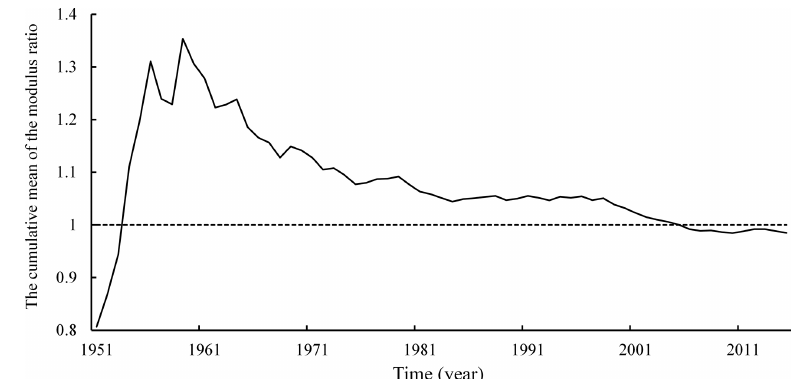
Figure 2. Beijing annual precipitation model ratio coefficient